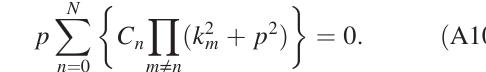
B.FIG. 6. Schematics of the integration contour for the inverse Laplace